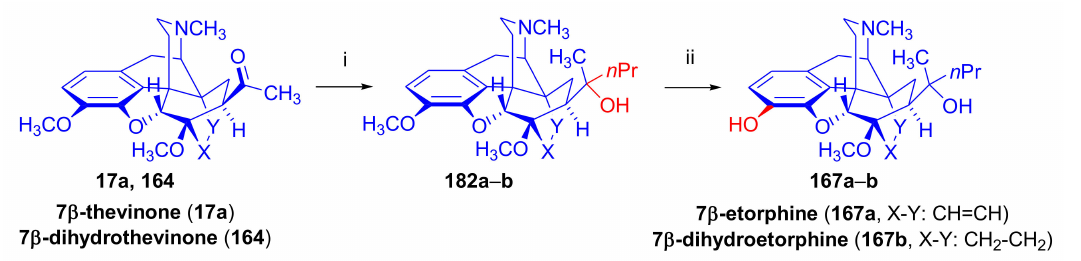
Figure 48. Synthesis of 7 β -etorphine and 7 β -dihydroetorphine. Reagents and conditions : (i): n - propylmagnesium bromide, toluene-diethyl ether, 2 h; (ii) KOH, diethylene glycol 210–220 ◦ C, 75